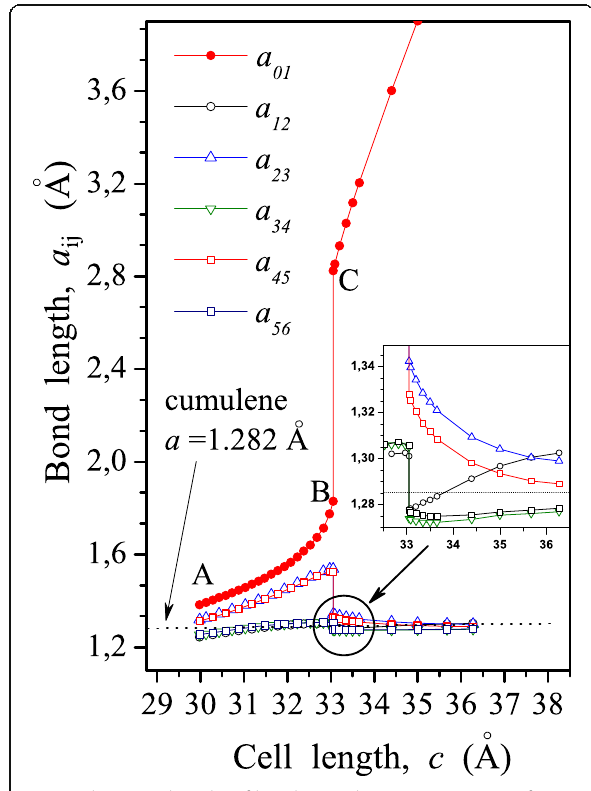
Fig. 5 Change in lengths of bonds in carbyne, a ij , at tension of